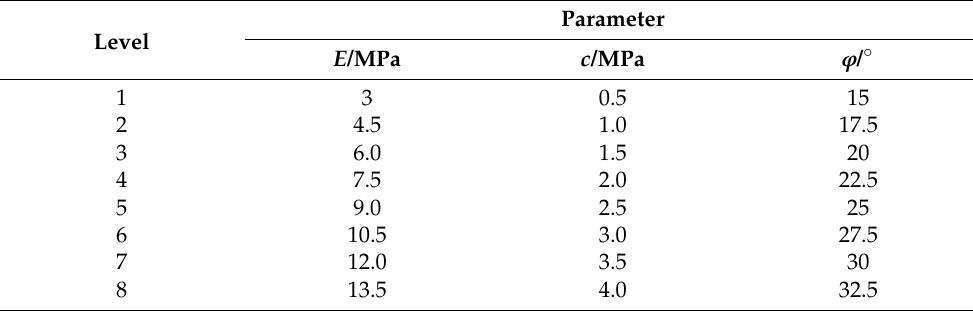
Table 2. Rock mechanical parameters and levels for orthogonal experimental.